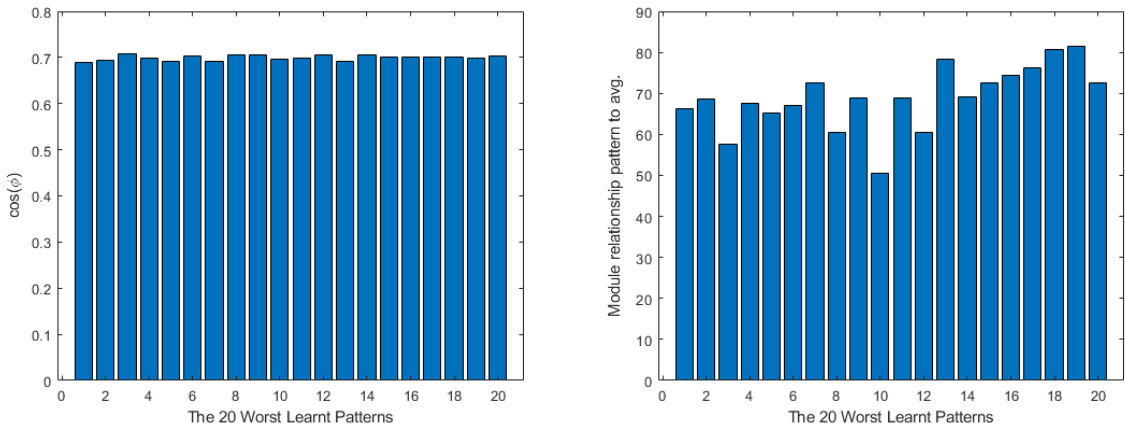
(cid:12) (cid:12) 𝜕𝐿𝑜𝑠𝑠 ∂ Loss (cid:12) (cid:12) | relationship to the average (cid:12) (cid:12) relationship to the average ∂ W n 𝜕𝑊 𝑛